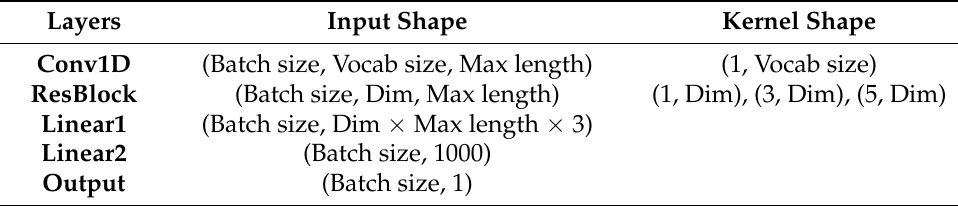
Figure 3. The Resblock. Table 1. The discriminator